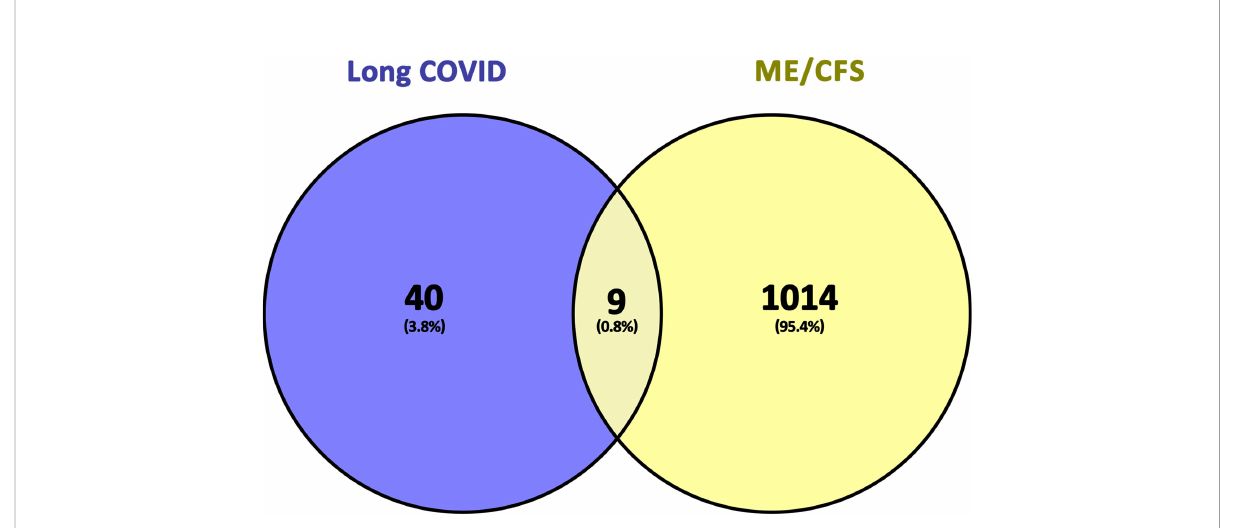
FIGURE 2 Common genes representation through a Venn diagram. 9 genes were found as common genes from 49 related genes of long COVID and 1023 related genes of ME/CFS.